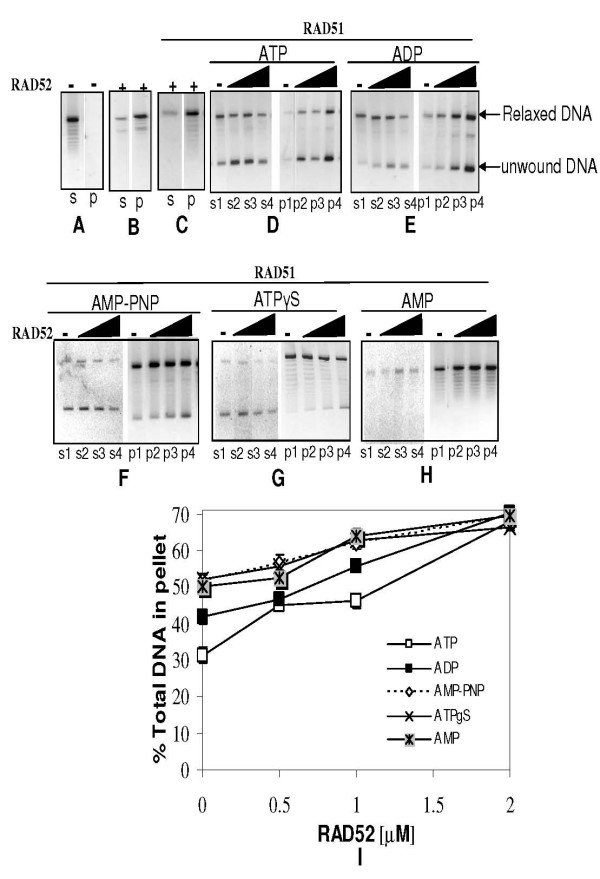
RAD52 promotes coaggregation of RAD52-RAD51-DNA complexes: centrifugation assay followed by DNA analysis. Centrifugation assay was carried out as explained in legend for Fig. 5. Panels (D-H) correspond to same samples described in Fig. 5, except that samples were deproteinized for DNA analyses (Methods). Controls: Lanes s and p of Panels A, B & C correspond to supernatant and pellet fractions for no proteins, RAD52 (2 μM) and [RAD51 (3 μM) plus RAD52 (2 μM)] controls respectively (all containing DNA without any nucleotide cofactors). Percentage of DNA (relaxed and unwound forms) in pellet fraction was expressed as a ratio of the total DNA (relaxed and unwound forms) in both pellet and supernatant fractions and plotted as a function of RAD52 concentration (Panel I).